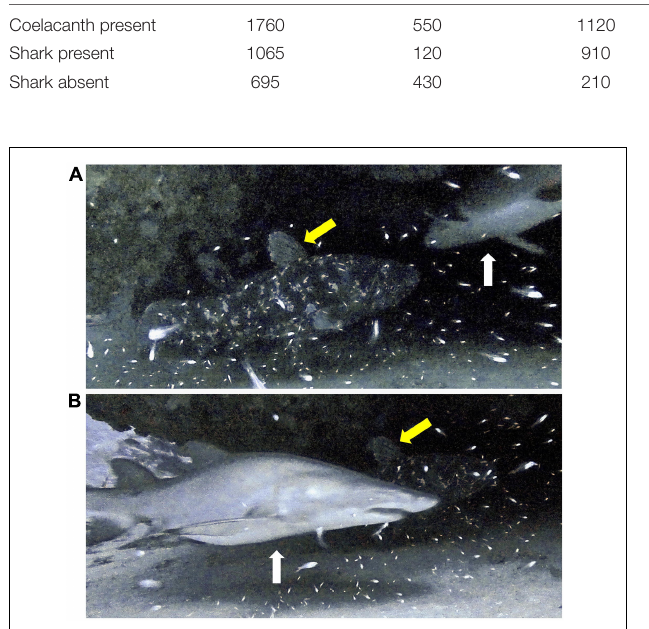
FIGURE 4 | Photographs of the coelacanth in the cave with its first dorsal fin unfolded (yellow arrow) when a shark (white arrow) was present and likely visible to the coelacanth (A,B) .